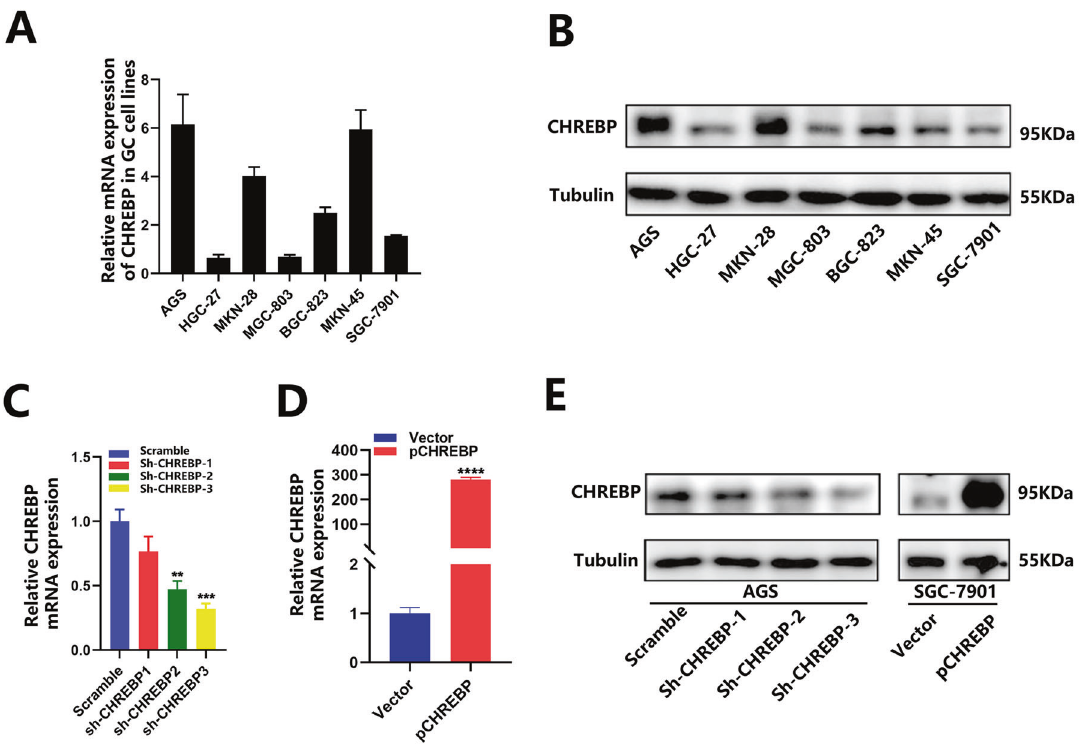
Fig. 2 CHREBP expression of GC cell lines. A , B CHREBP expression of 7 GC cell lines was examined by qRT – PCR and WB. C – E CHREBP knockdown in AGS cells and CHREBP overexpression in SGC-7901 cells were detected by qRT – PCR and WB. Sh-CHREBP-3 was selected for the